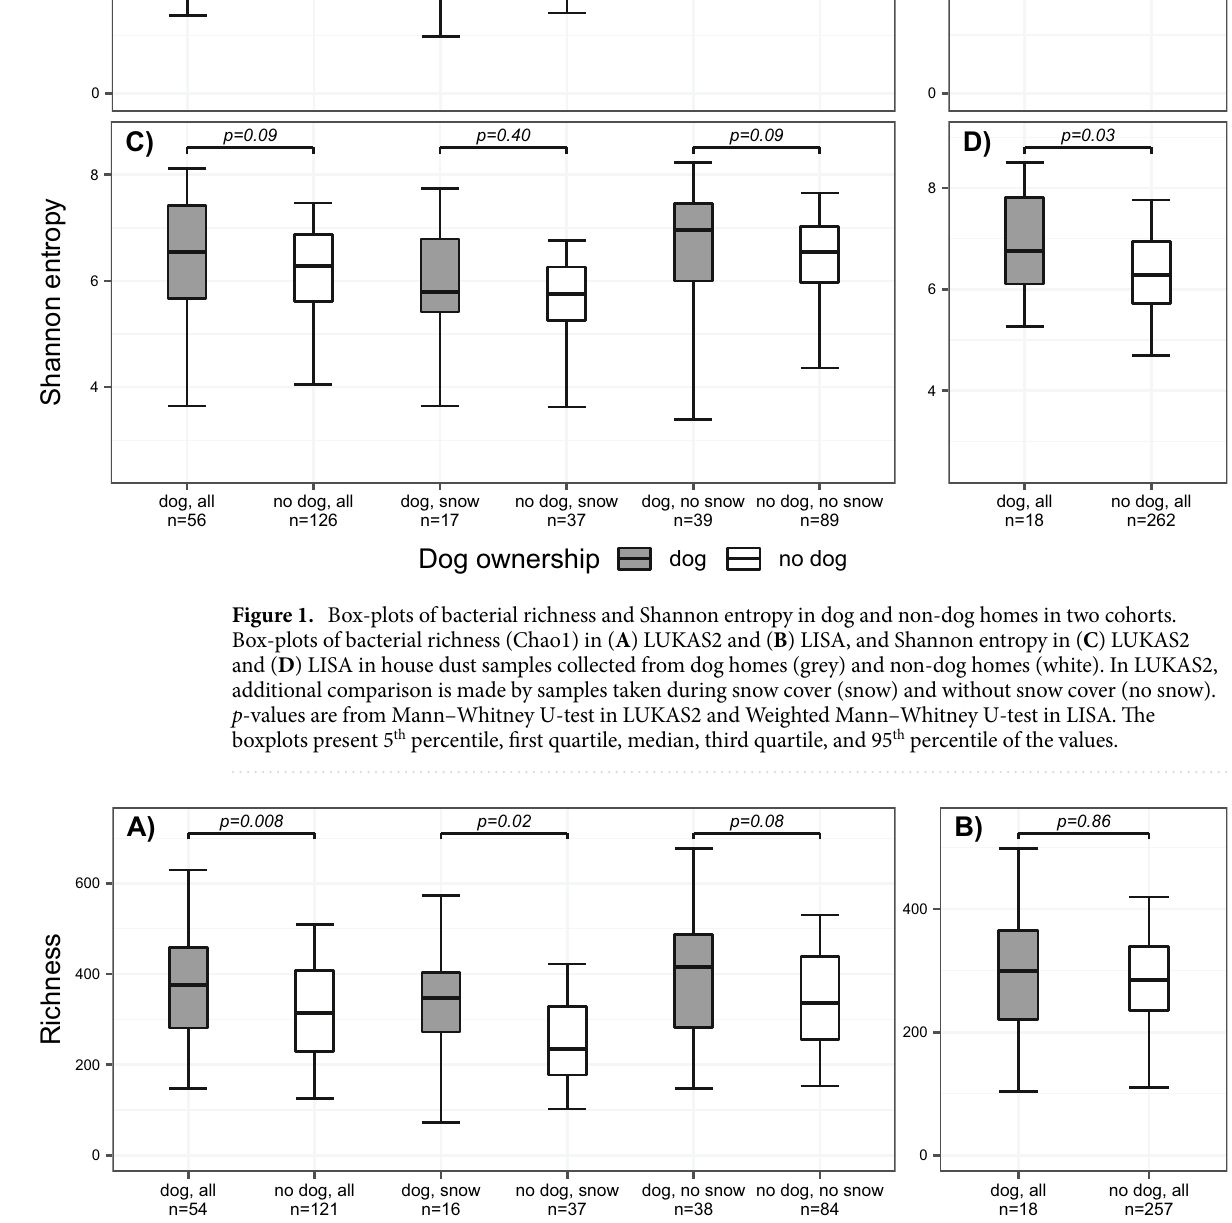
Figure 2. Box-plots of fungal richness in dust samples from dog and non-dog homes in two cohorts. Box-plots of fungal richness (Chao1) in house dust samples collected from dog homes (grey) and non-dog homes (white) in ( A ) LUKAS2 and ( B ) LISA cohorts. In LUKAS2, additional comparison is made by samples taken during snow cover (snow) and without snow cover (no snow). p -values are from Mann–Whitney U-test in LUKA S2 and Weighted Mann–Whitney U-test in LISA. The boxplots present 5 th percentile, first quartile, median, third quartile, and 95 th percentile of the